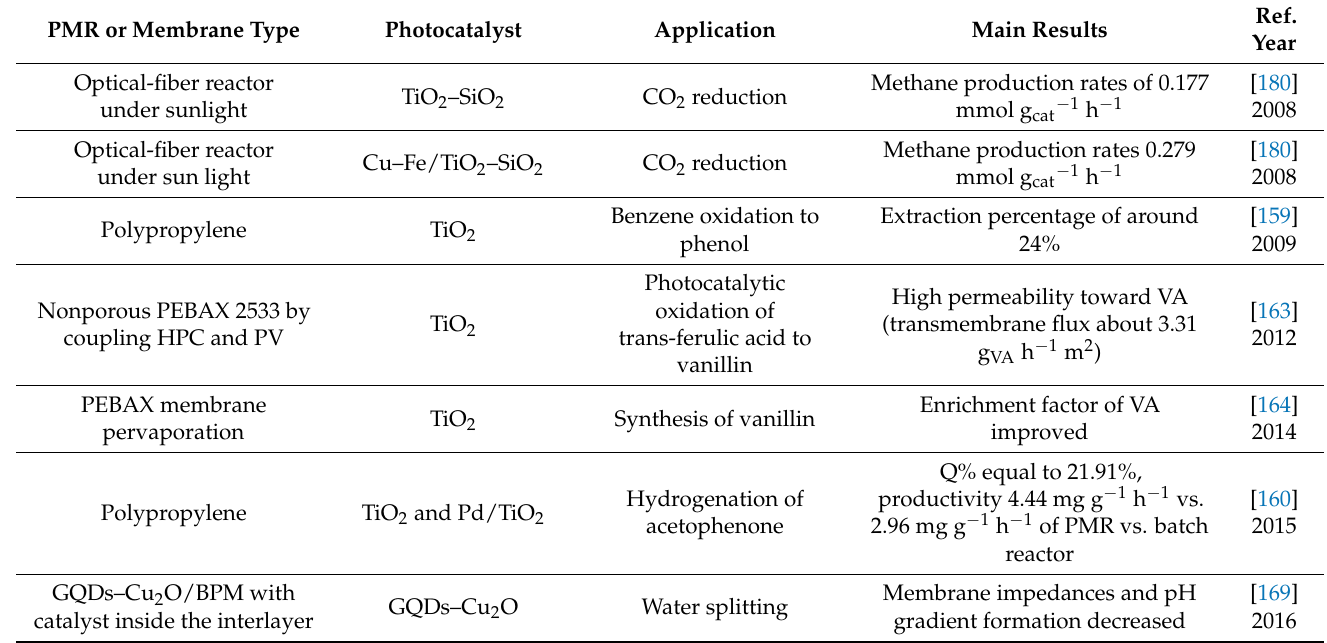
Table 4. Summary of some PMRs tested in organic synthesis and the main